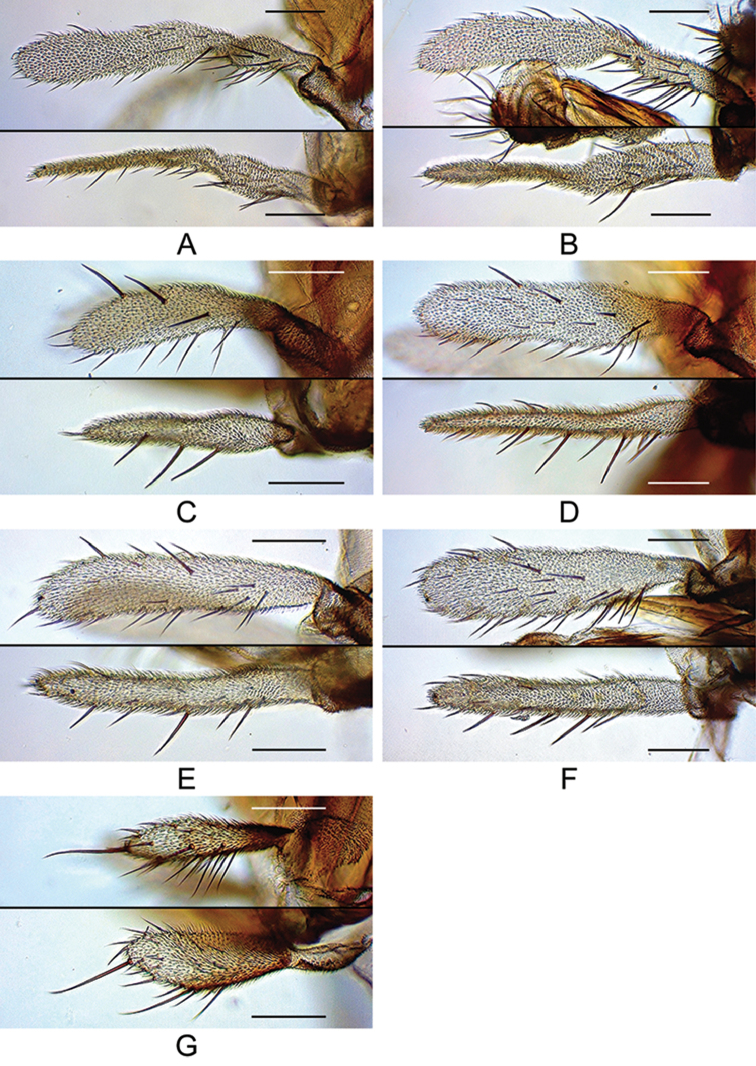
Palpus (lateral and dorsal views; only A is photographed at right side and flipped horizontally). Amalayana (Takada) (#03903) Bgracilipalpis sp. n. (paratype #00492) Cpuberula sp. n. (paratype #03366) Dalbipalpis sp. n. (holotype #03908) Eqiongzhouensis sp. n. (paratype #03313) Forthophallata sp. n. (paratype #03905) Gdissimilis sp. n. (holotype #00430). Scale bars: 0.1 mm.